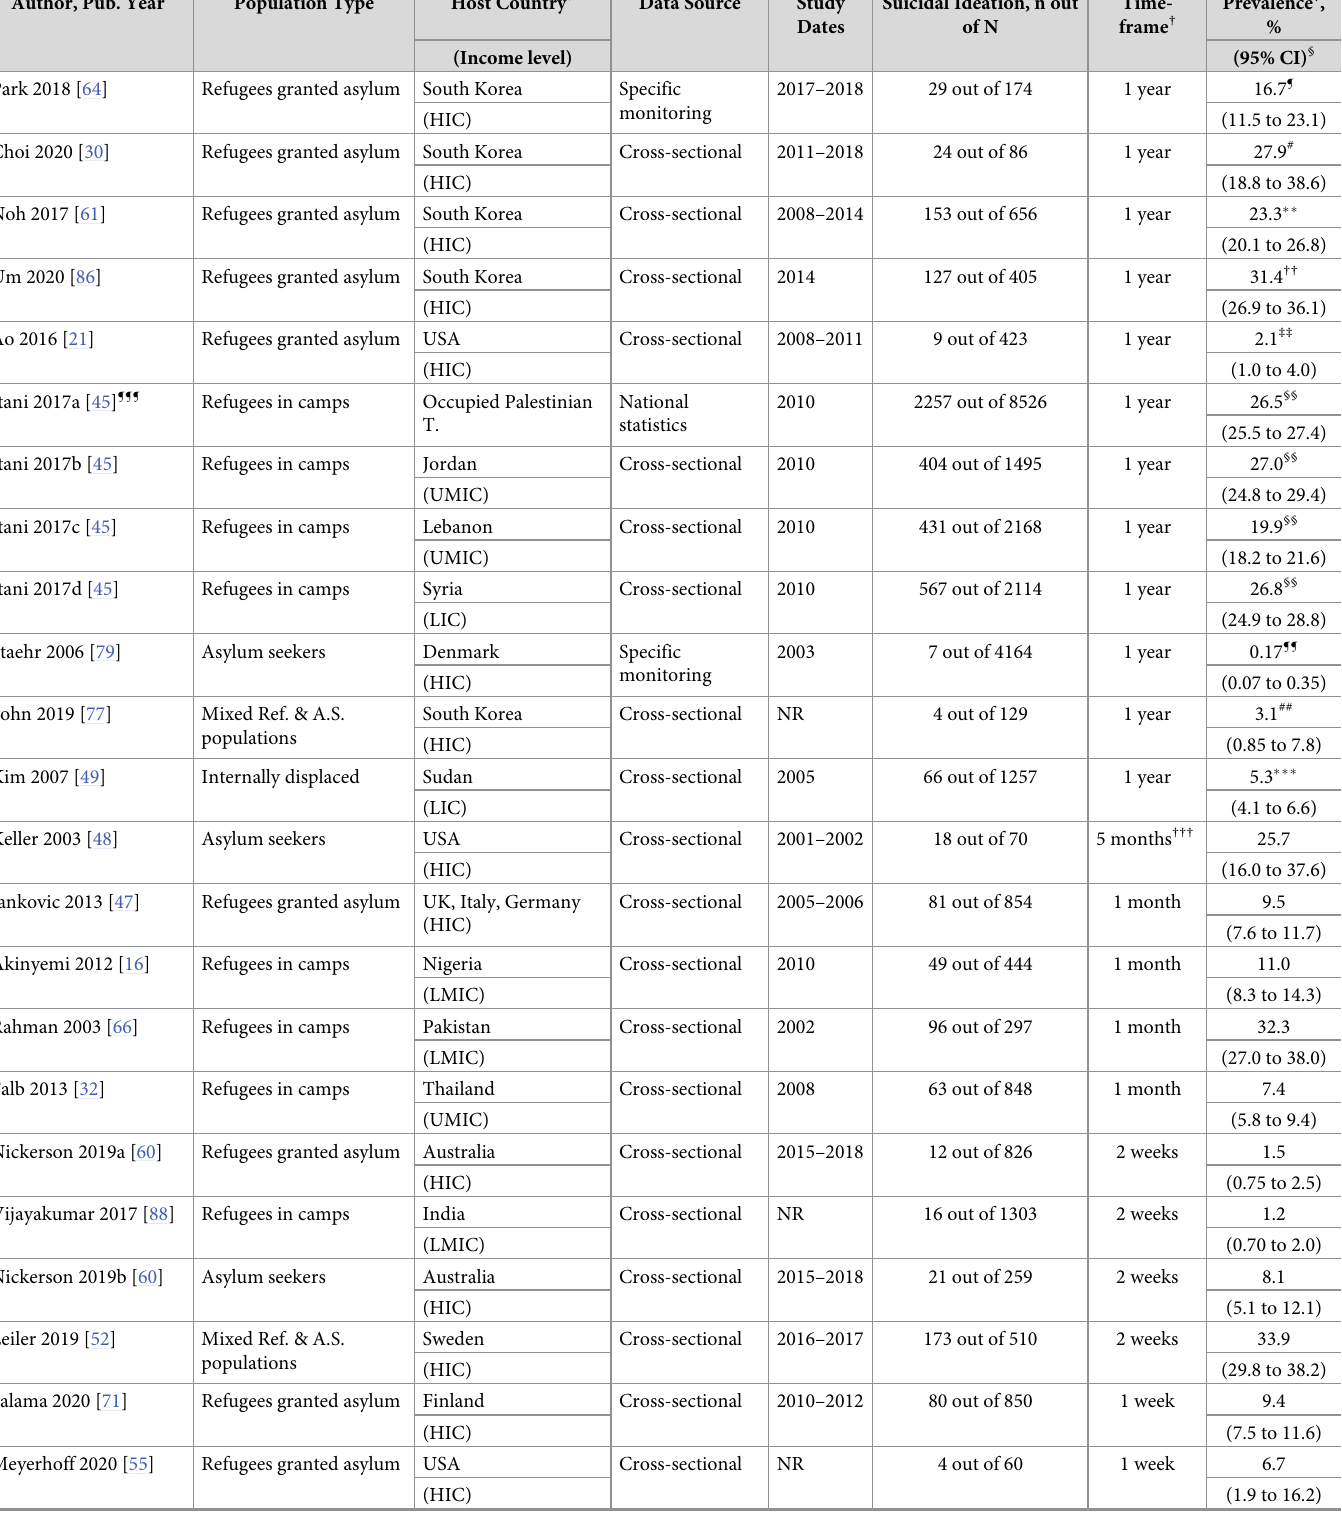
Table 4. Suicidal ideation prevalence percentage in general samples, ordered by timeframe (and then by population type). Author, Pub.